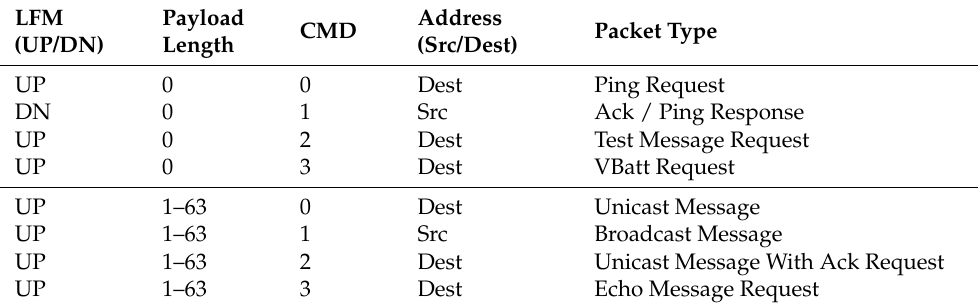
Table 2. Packet message header structure.